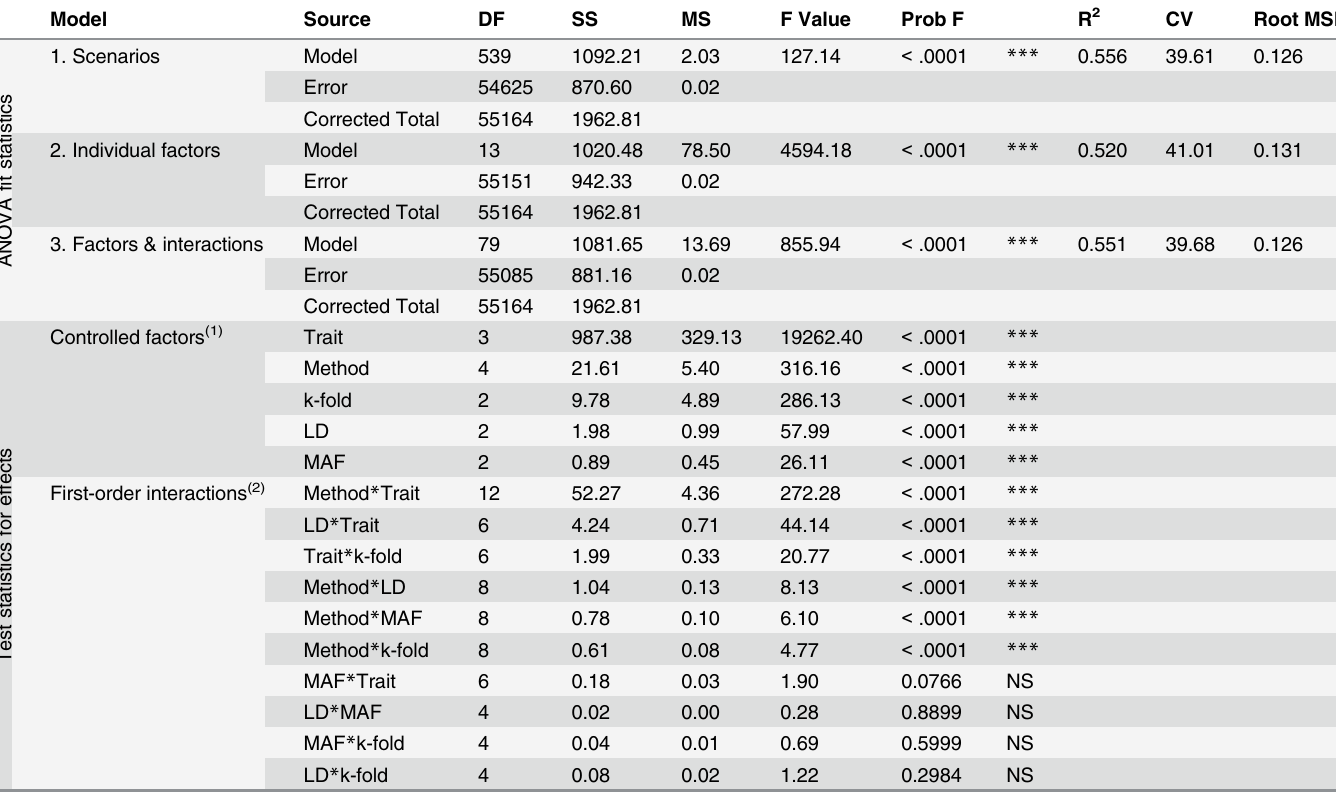
Table 4. Sources of variation of the AA in the first cross validation experiment considering 540